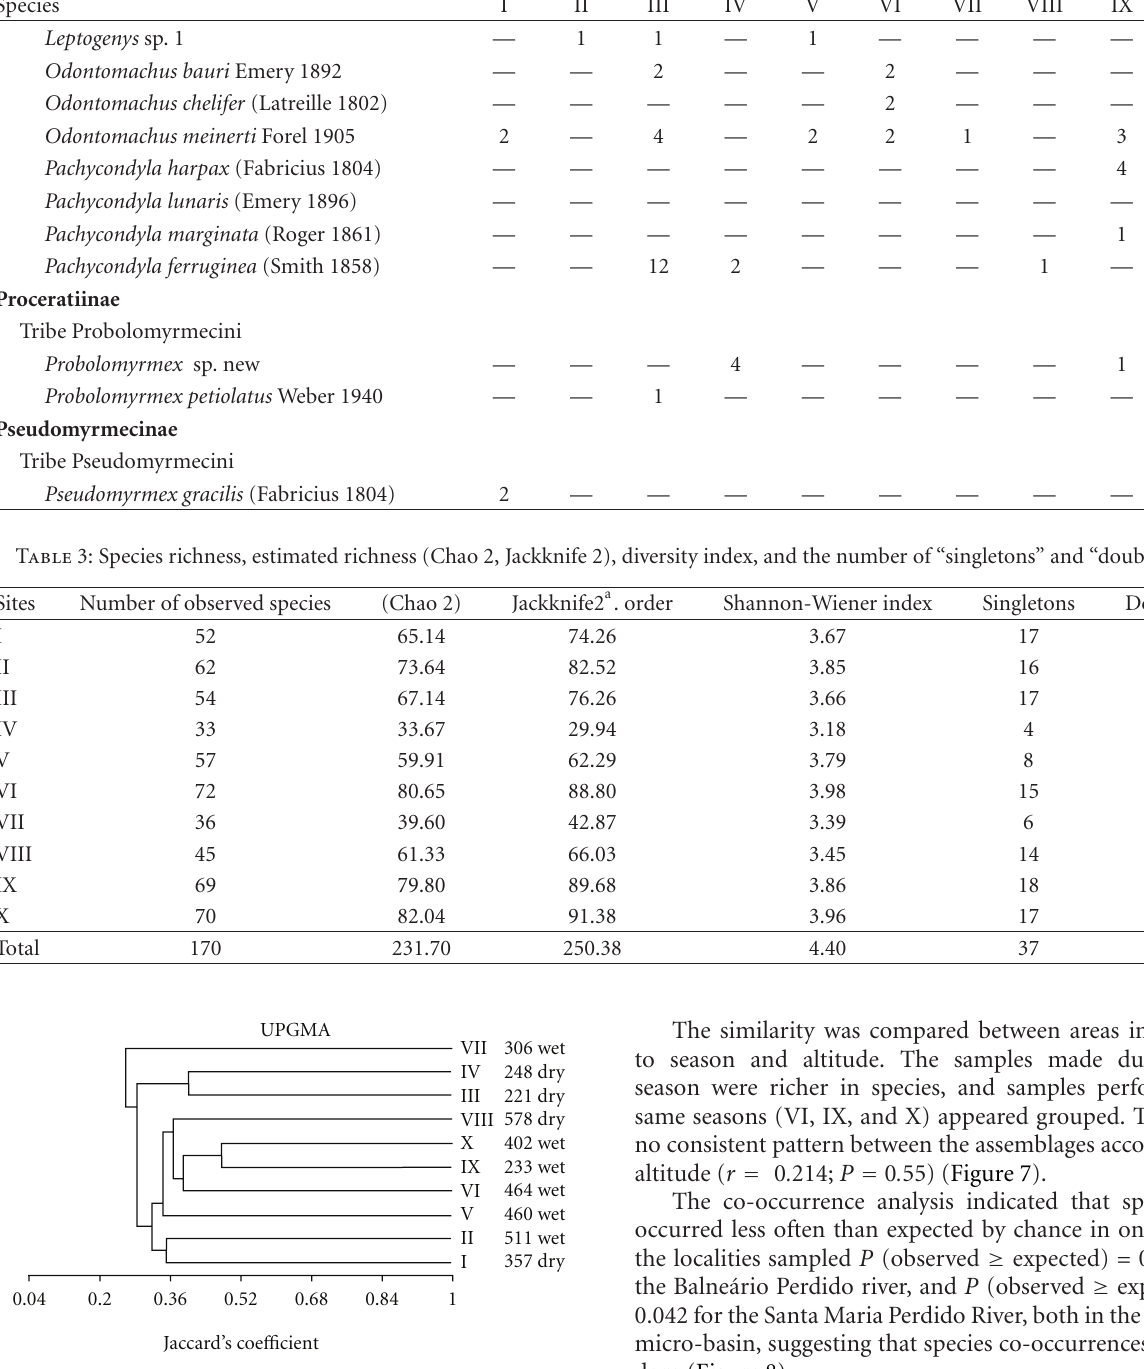
and the geographical distance (km) between the sites ( r = − 0 . 002; P = 0 . 49) (Table 4; Figure